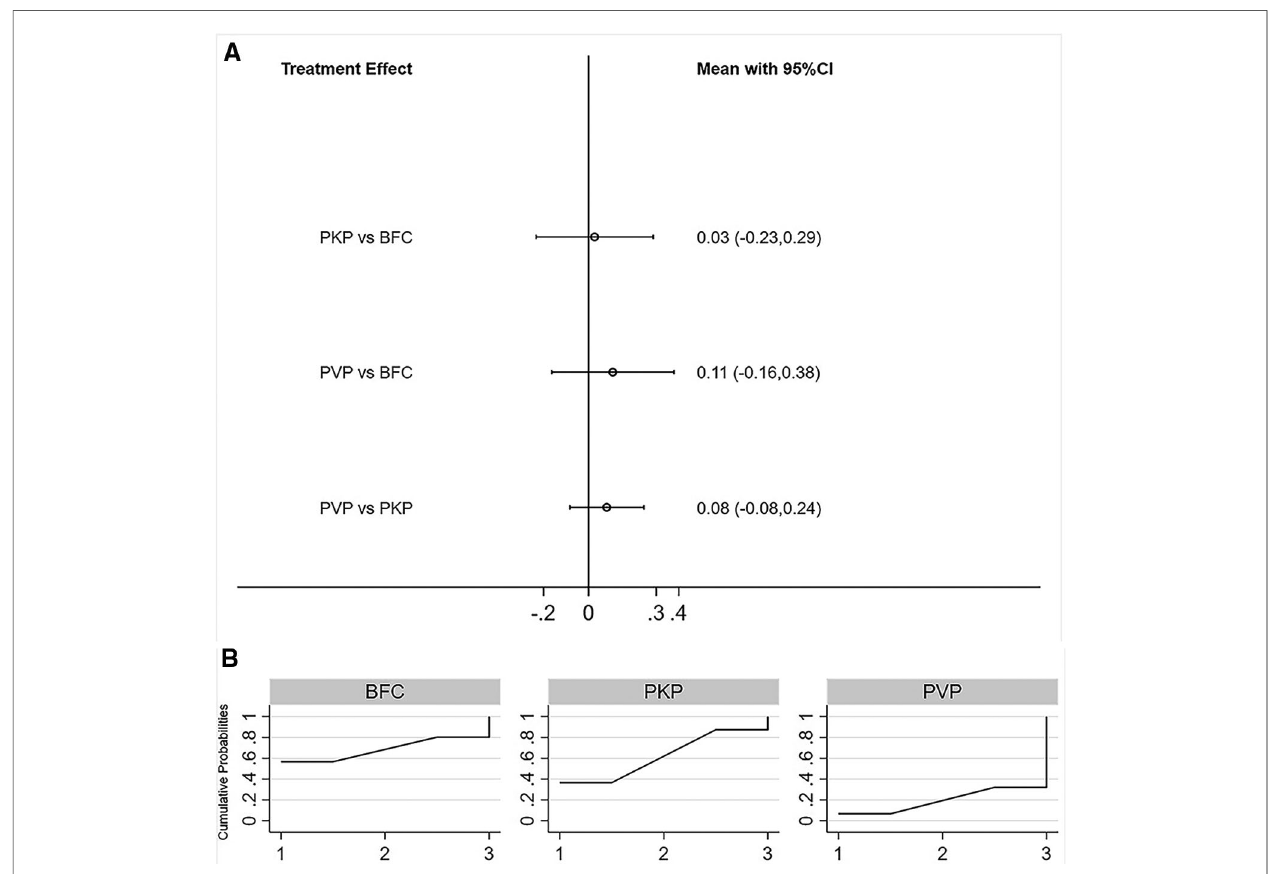
FIGURE 2 | Forest plot of VAS score ( A ) and relevant SUCRA of each procedure ( B ). PVP, percutaneous vertebroplasty; PKP, Percutaneous kyphoplasty; BFC, bone- fi lling mesh